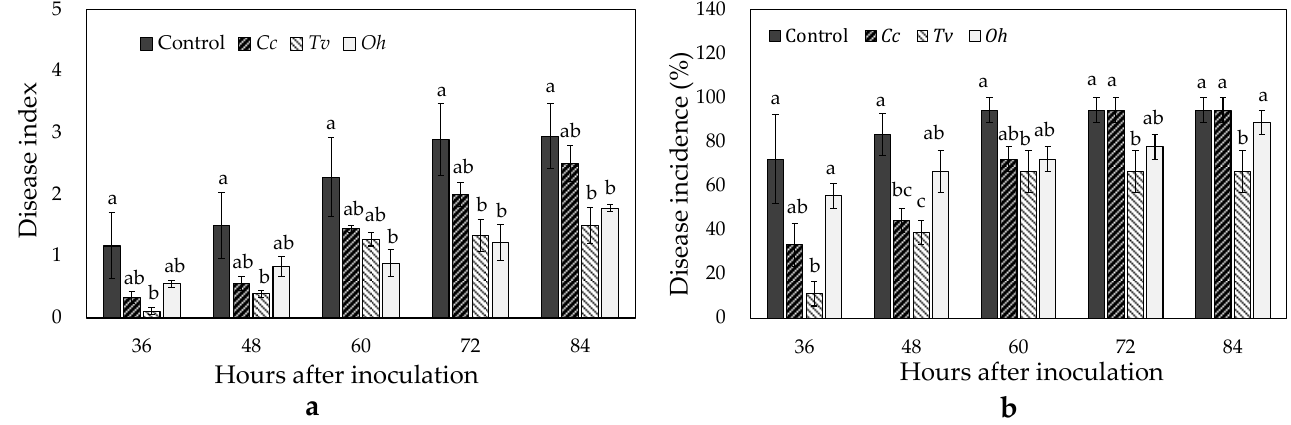
Figure 5. Effects of Cymbopogon citratus ( Cc ), Thymus vulgraris ( Tv ), and Origanum heracleoticum ( Oh ) essential oil vapor treatments on disease index ( a ) and disease incidence ( b ) of strawberry fruit artificially inoculated with Botrytis cinerea spore suspension. Each value represents the mean of eight replicates. Means with different letters are significantly different based on Ducan’s test ( p ≤ 0.05).